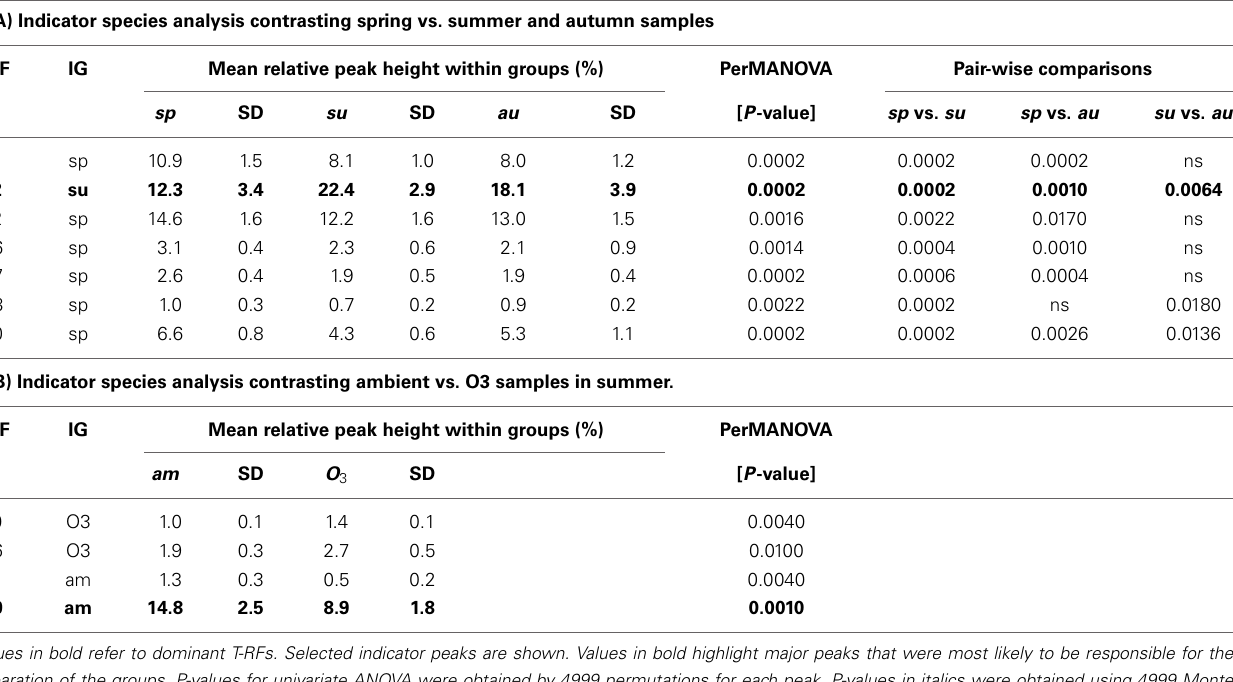
Frontiers in Microbiology | Plant-Microbe